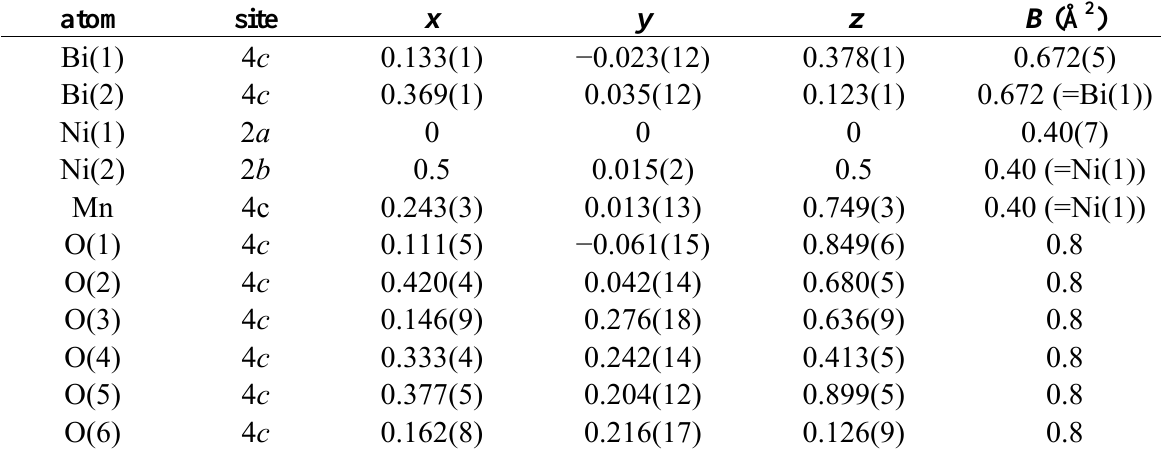
NiMnO at room temperature. Space group C 2 6